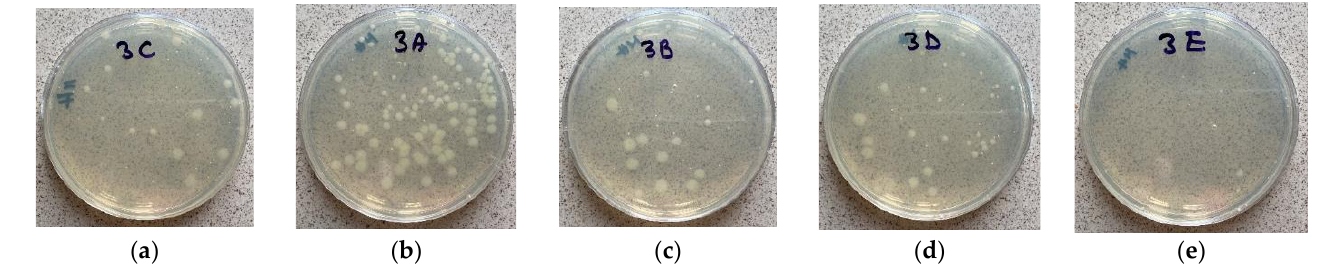
Figure 5. Microbial colonies after the disinfection with Zeta 3 Soft for each impression material: ( a ) Tropicalgin; ( b ) Zetaplus; ( c ) Oranwash L; ( d ) Elite HD + Putty Soft; ( e ) Elite HD + Light Body.